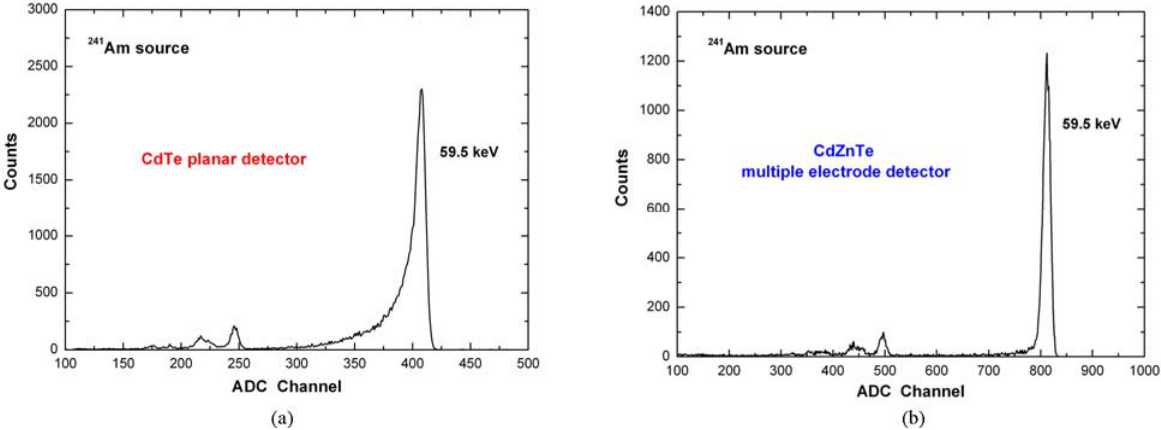
Figure 19 . (a) The 241 Am spectrum measured with the CdTe planar detector; it shows an energy resolution of 2.7 % FWHM at 59.5 keV (T = -20 °C) [67]. (b) The measured 241 Am spectrum with the CdZnTe multiple electrode detector; it shows an energy resolution of 1.9 % FWHM at 59.5 keV (T = -10 °C) [64]. It is clearly visible the small tail of the 59.5 keV photopeak of the spectrum measured with the CdZnTe multiple electrode